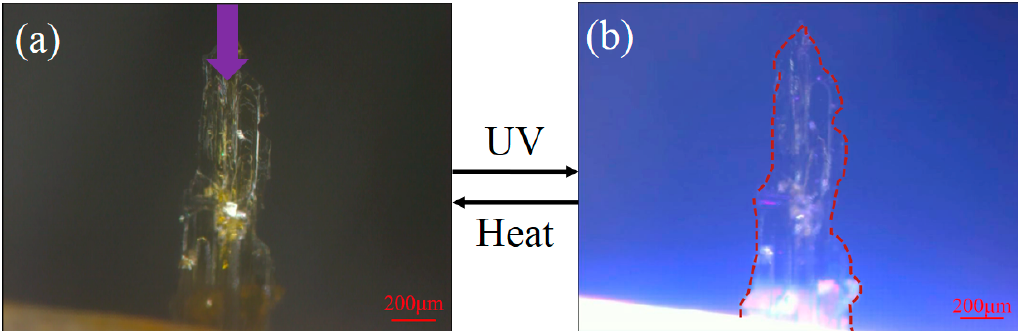
Figure 6. Photomechanical motion of plate-like crystal (1499 µ m × 337 µ m × 10 µ m) of 6cazpy: ( a ) Before and ( b ) after UV irradiation from up-front on the image (indicated by the purple arrow) and the red dashed line is the original position of crystal.